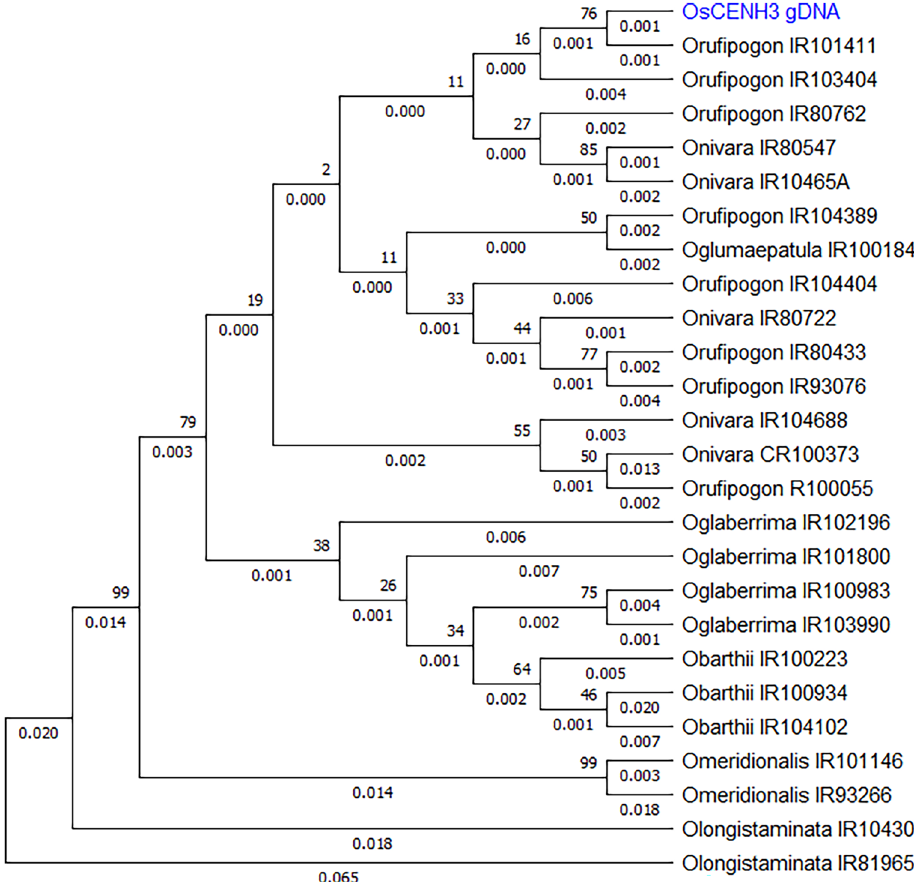
Figure 4. Phylogenetic analysis of sampled CENH3 alleles: Dendrogram generated using complete CENH3 sequences of 25 Oryza accessions in MEGA version X at bootstrap 1000 using neighbor-joining method. Accessions as listed in Table 1. Reference clustered closest to O. rufipogon and O. nivara